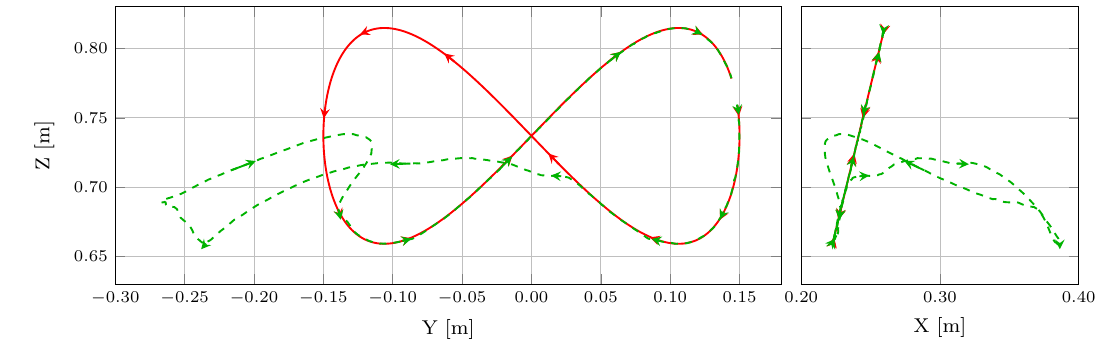
Fig. 15 Cartesian reference (solid) and measured position (dashed) of the end-effector of the COMPI manipulator when disturbed while moving along a reference trajectory without payload . Time indicated by arrows at every